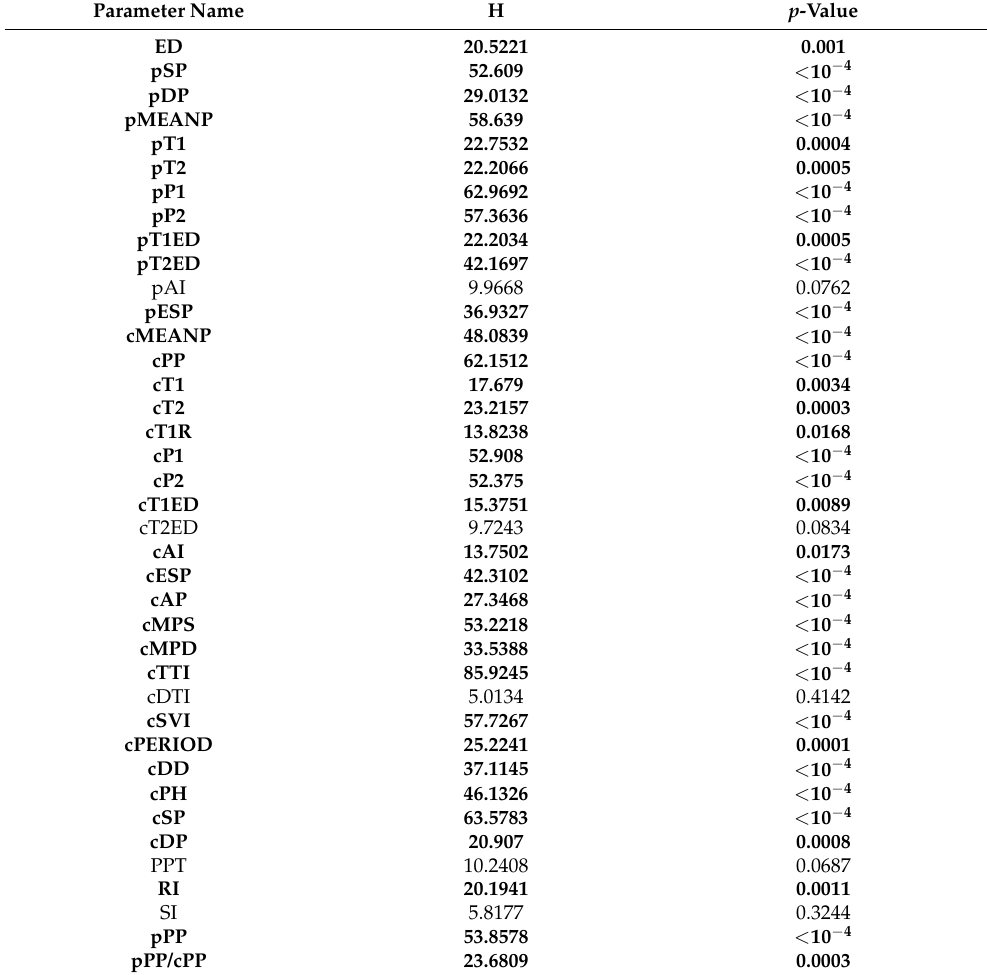
Table 3. Differences between groups presented as results of the Kruskal–Wallis H test for each cardiovascular parameter analyzed. The critical value of H statistic is equal to 11.07. Strong differences are marked with bold